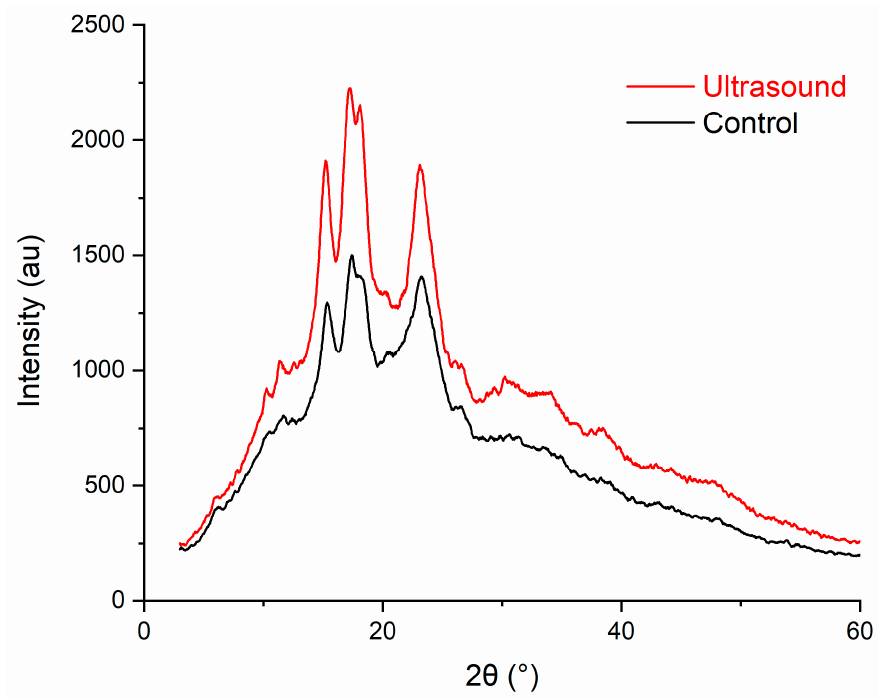
Figure 7. XRD patterns of control and ultrasound-extracted sago starches.